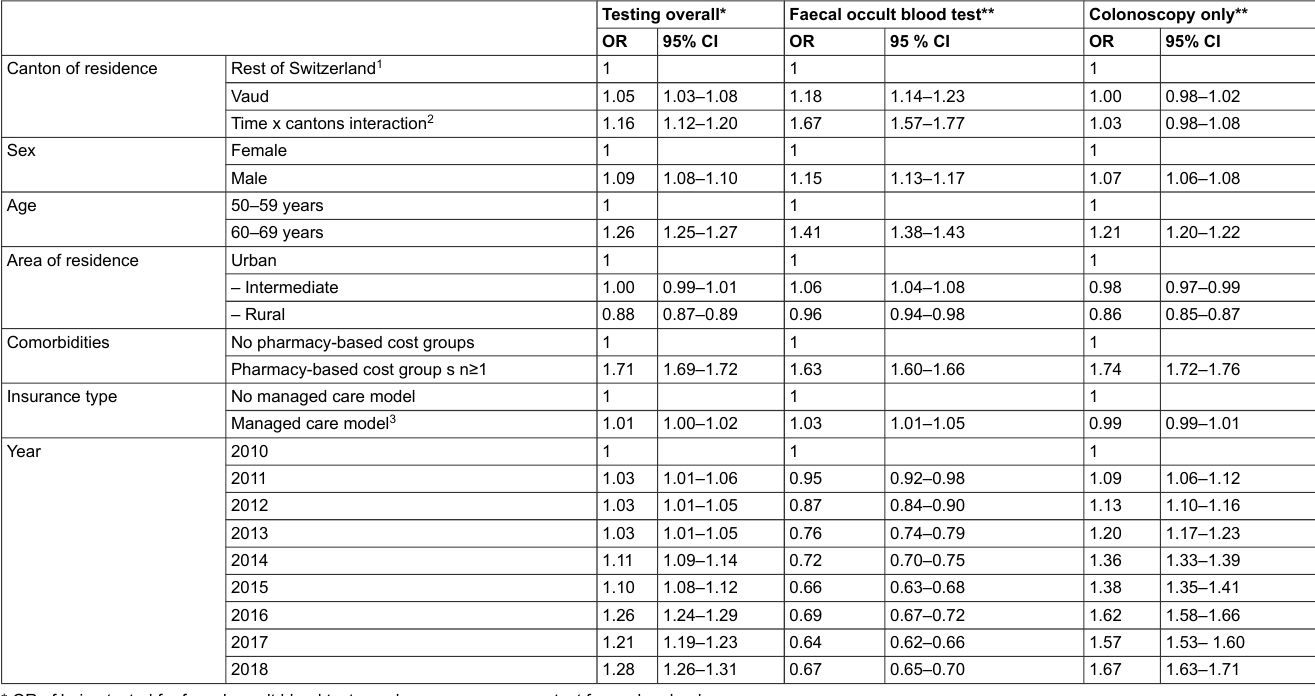
Table S2: Odds ratio of being tested for colorectal cancer within each calendar year (2011–2018) for 50–69-year old insures, in (A) Any test for colorectal cancer (faecal occult blood test or colonoscopy)*, B) faecal occult blood test** or C) colonoscopy)**; in canton Vaud compared to neighbouring cantons & the rest of Switzerland (i.e. all other cantons) before and after the launch of the Vaud organized screening program in 2015. CSS database.